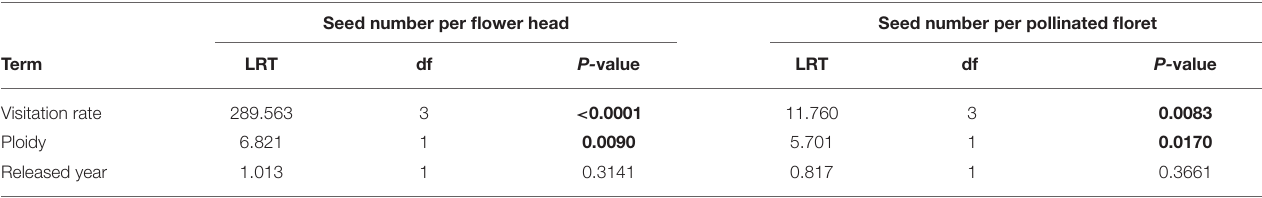
TABLE 2 | The effects of visitation rate, ploidy, and released year on the seed number per flower head [generalized linear mixed model (GLMM)] and seed number per pollinated floret [cumulative link mixed model (CLMM)].